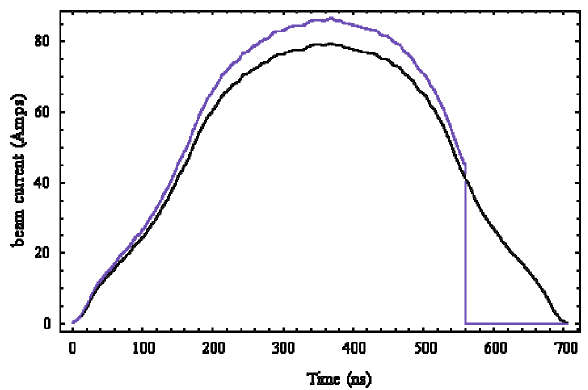
FIG. 14. (Color) SNS beam current profile cut at 560 ns, com- pared to the nominal